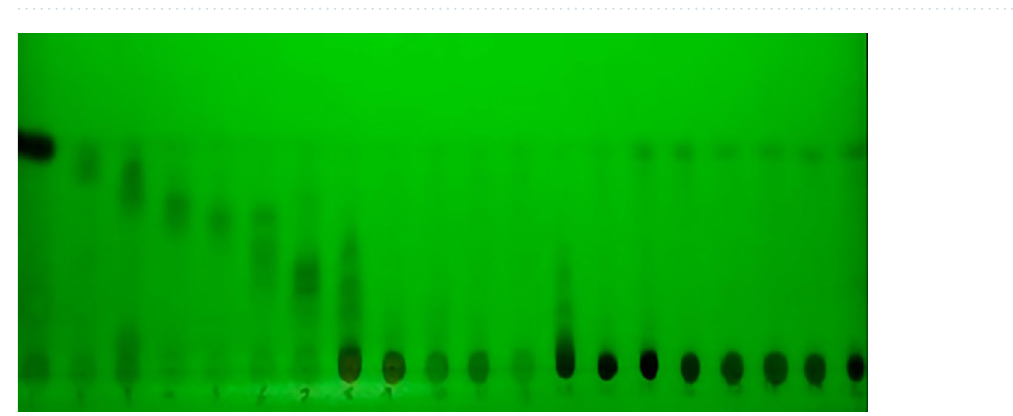
Figure 2. The 250 fractions combined (with the same RF value)